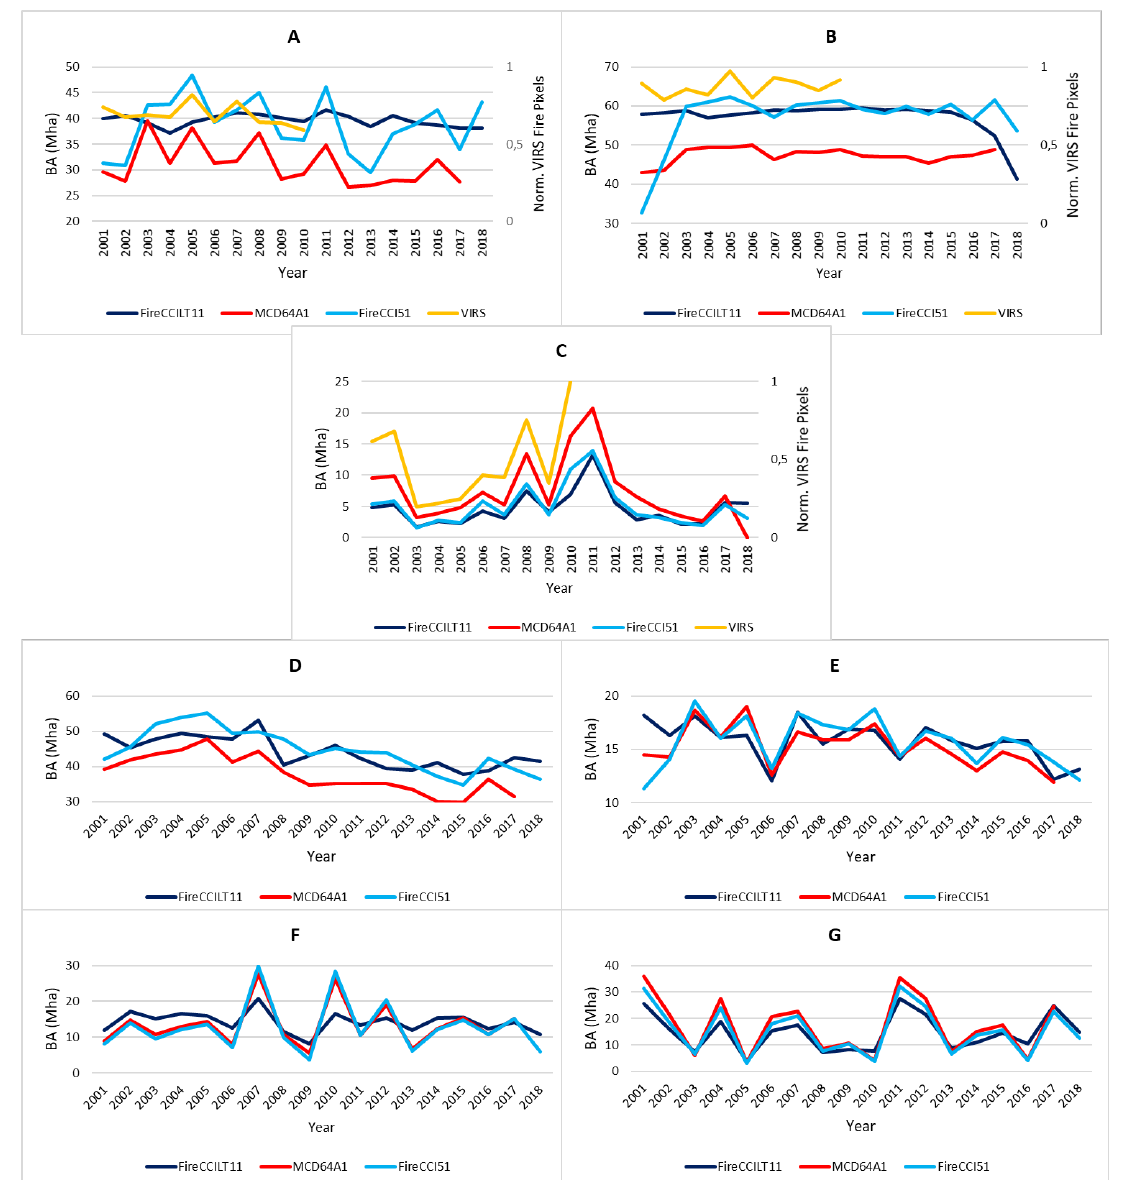
Figure 4. Annual time series analysis for the seven regions shown in Figure 3. Total annual FireCCILT11, FireCCI51 and MCD64A1 BA for the 2001–2018 time series for each region, with ( A – C ) corresponding to 2001–2010 normalized annual TRMM VIRS active fire counts. Zone ( D ) r = 0.71 in 2001–2018 and r = 0.80 in 2003–2018, Zone ( E ) r = 0.54 in 2001–2018 and r = 0.85 in 2003–2018, with also high values in the other tropical zones: Zone ( F ) r = 0.81 and Zone ( G ) r = 0.95 in